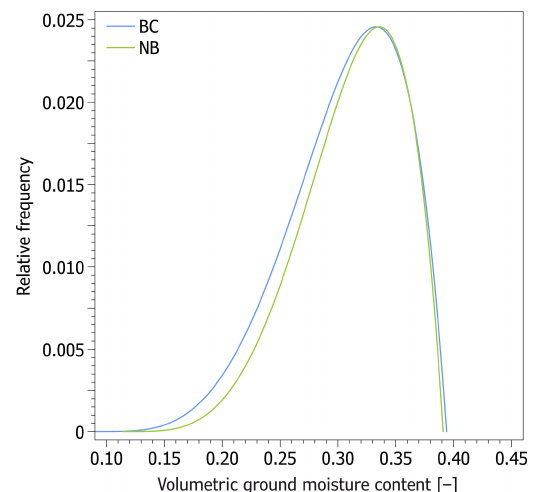
Figure 5. Probability distributions of volumetric ground moisture contents assumed for the Brno–ˇCernovice (BC) and Nebanice (NB)